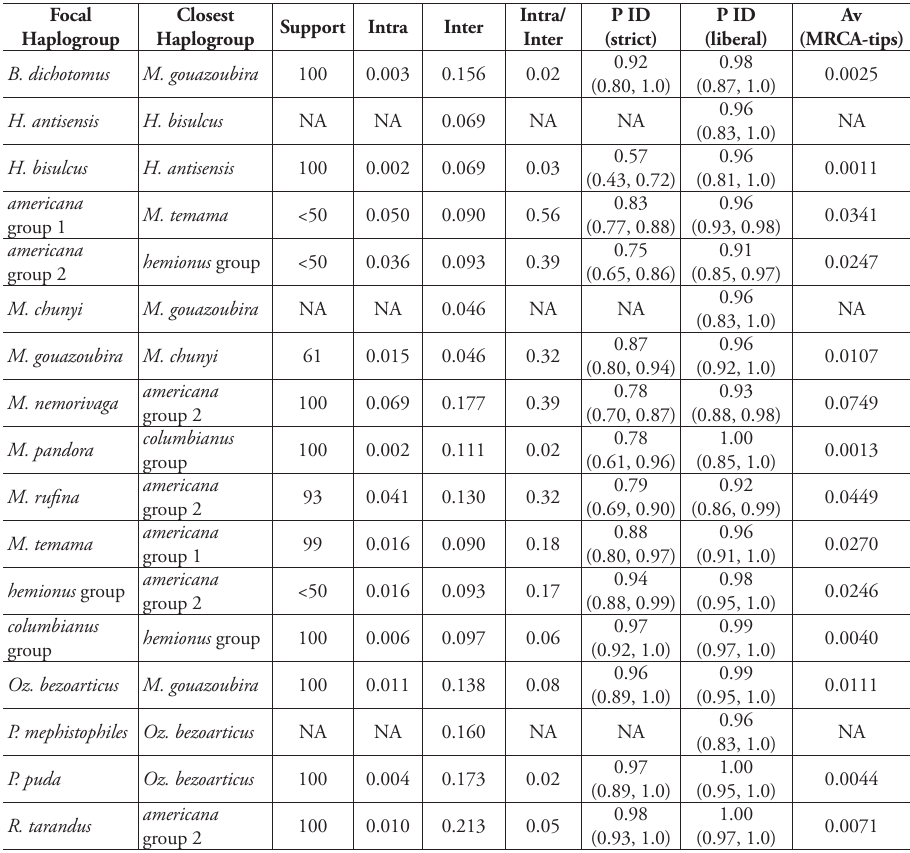
Table 2. Summary statistics from the Species Delimitation plugin of Geneious for haplogroups of Rang- iferini and Odocoileini deer recovered in the maximum-likelihood tree. Focal haplogroup support: boot- strap values; Intra: The average pairwise tree distance among members of the focal haplogroup; Inter: the average pairwise tree distance between the focal haplogroup and the members of the closest haplogroup; Intra/Inter: the ratio of Intra to Inter; P ID (strict): the mean (95% confidence interval) probability of correctly identifying an unknown member of the focal haplogroup using the criterion that it must fall within, but not sister to, the species clade in a tree; P ID (liberal): the mean (95% confidence interval) probability of correctly identifying an unknown member of the putative species using the criterion that it falls within, or sister to, the species clade in a tree; Av (MRCA-tips): the mean distance between the most recent common ancestor of a haplogroup and its